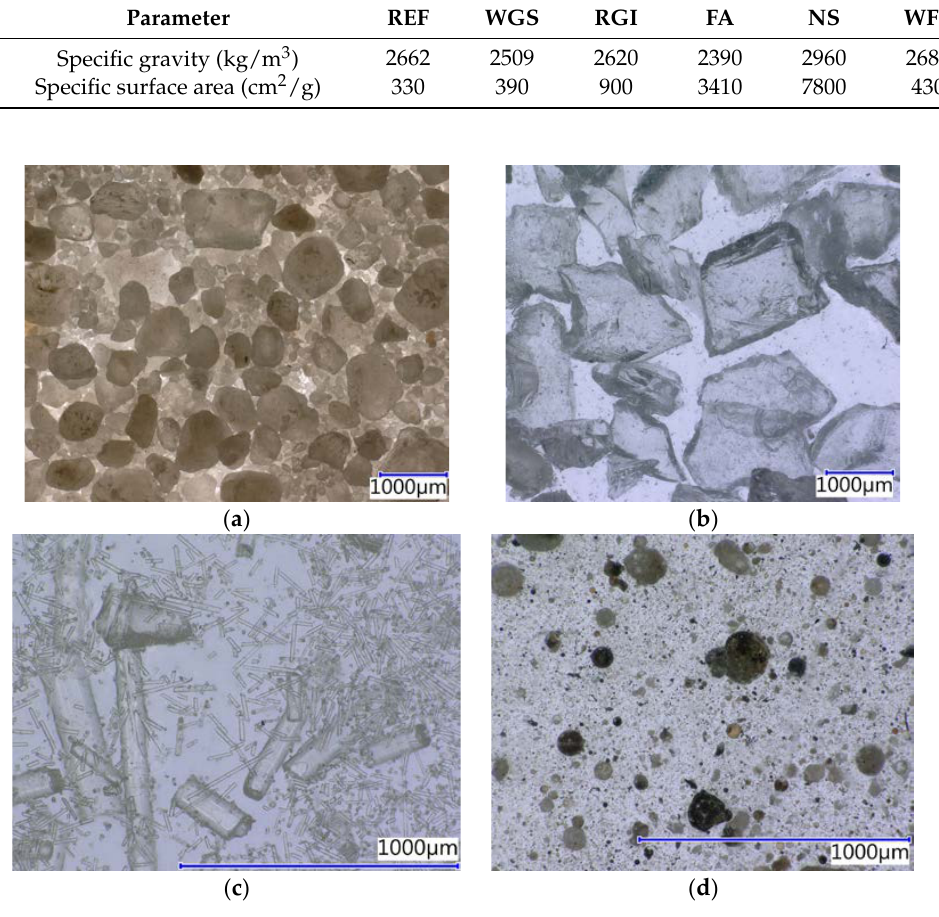
Figure 3. Particle size distribution of the fillers determined by Mastersizer 2000 laser diffraction particle size analyser (REF—Reference filler, WGS—Waste glass from solar panels, RGI—Waste from the production of mineral insulation boards, FA—Fly ash, NS—Neutralization sludge, WFS—Waste foundry sand). Table 4. Basic properties of the fillers.